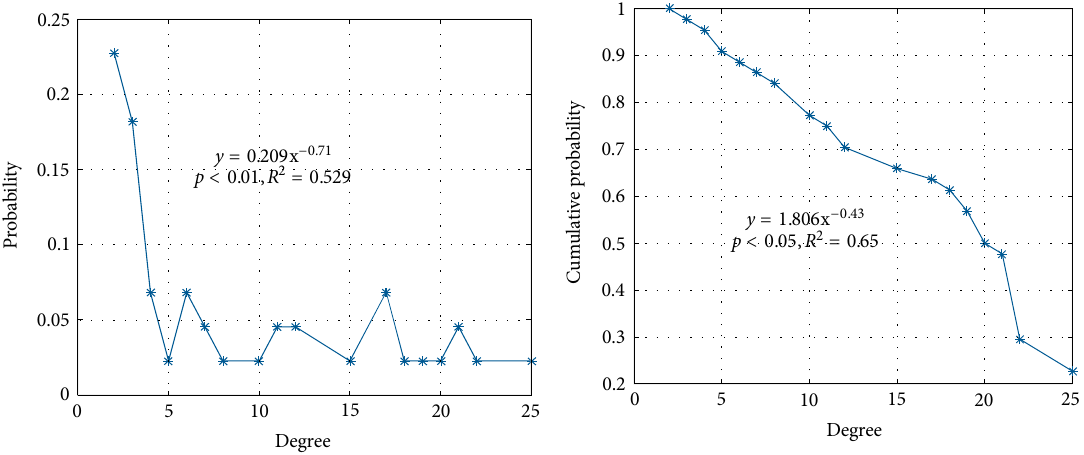
Figure 6: CRECN node degree probability distribution and cumulative probability distribution for